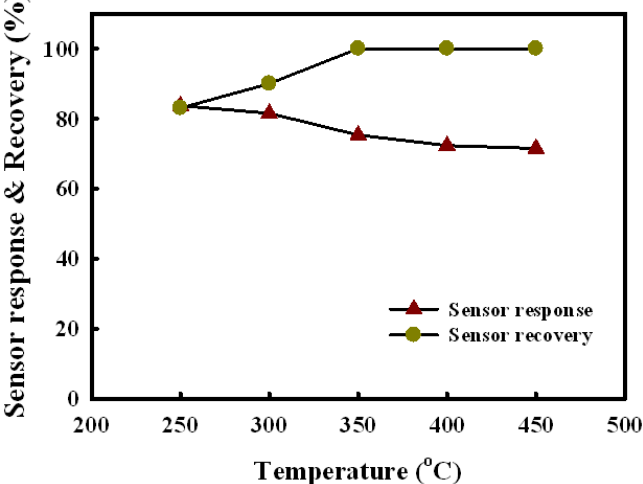
Figure 6. Responses and recovery of the Sn(12)Mo5Ni3 sensor as a function of the detection temperature at a H S concentration of 1.0 2